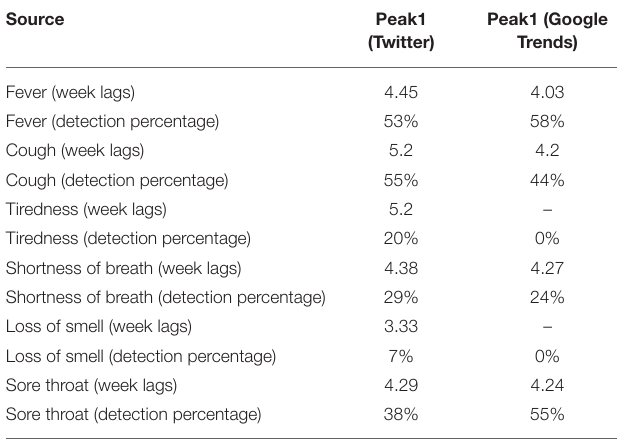
TABLE 5 | The average prediction values of the US states (detection of early